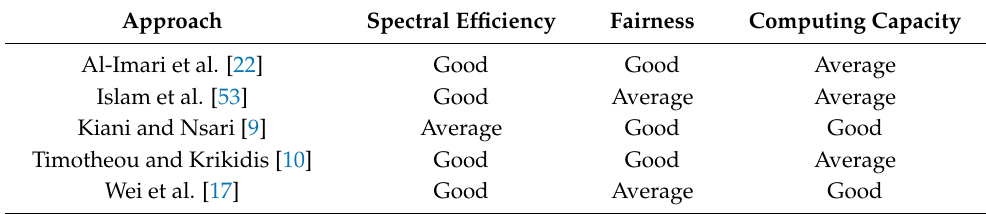
Table 6. Summary of NOMA-based approaches in 5G